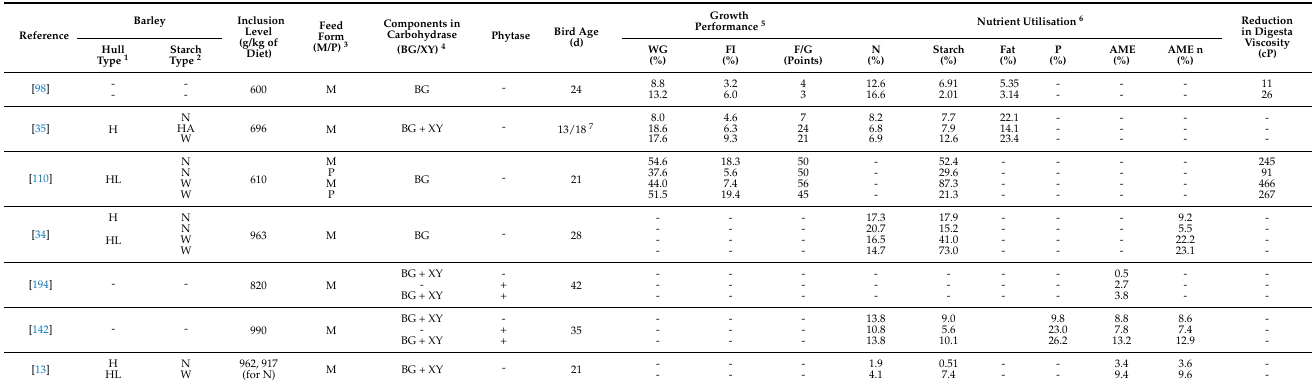
Table 10. Response of growth performance, nutrient utilisation and intestinal digesta viscosity of broilers fed barley-based diets to supplemental